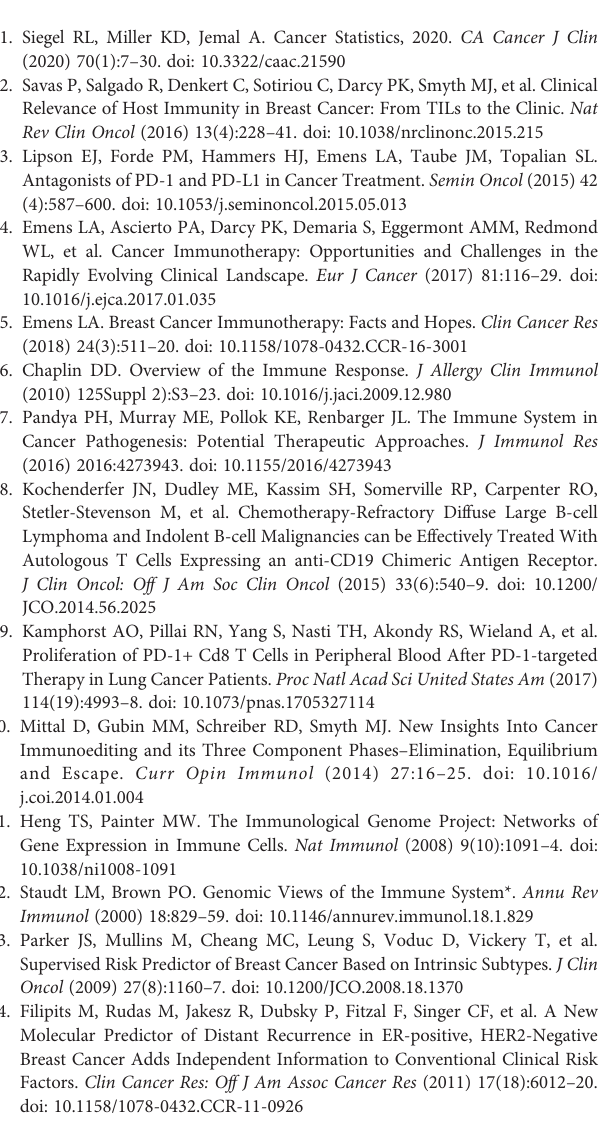
Supplementary Figure 1 | The fi gure of the soft threshold power by WGCNA.